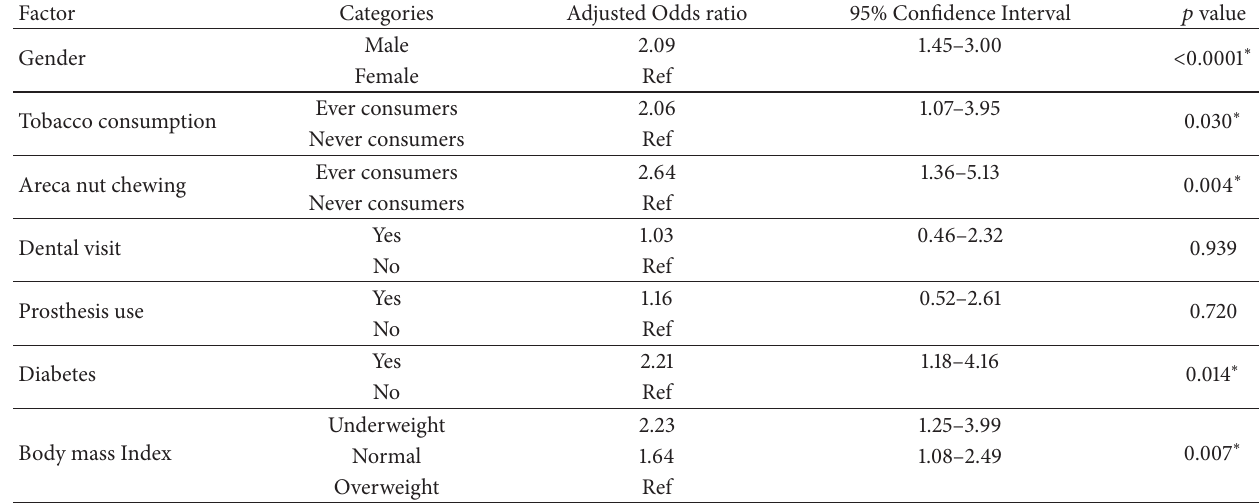
Table 5: Logistic regression analysis with presence of oral potentially malignant disorders as dependent